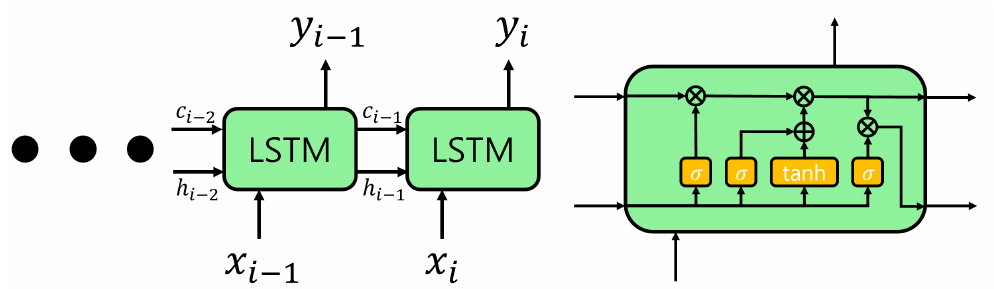
Figure 9. Learning process of LSTM.